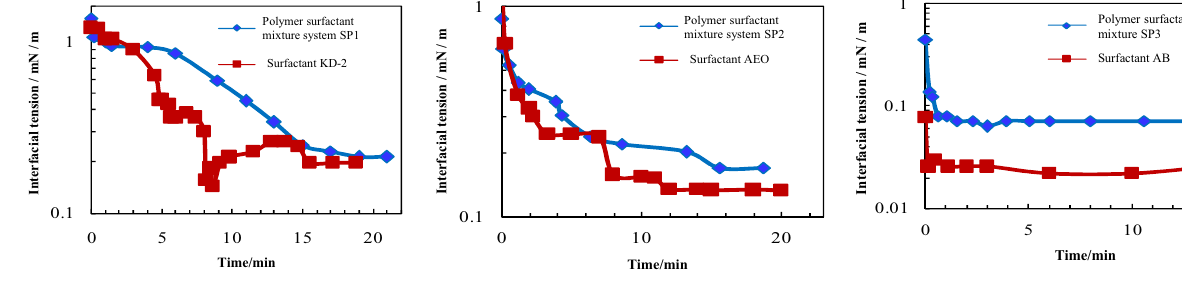
Fig. 6 IFT measurement results of surfactant mixtures